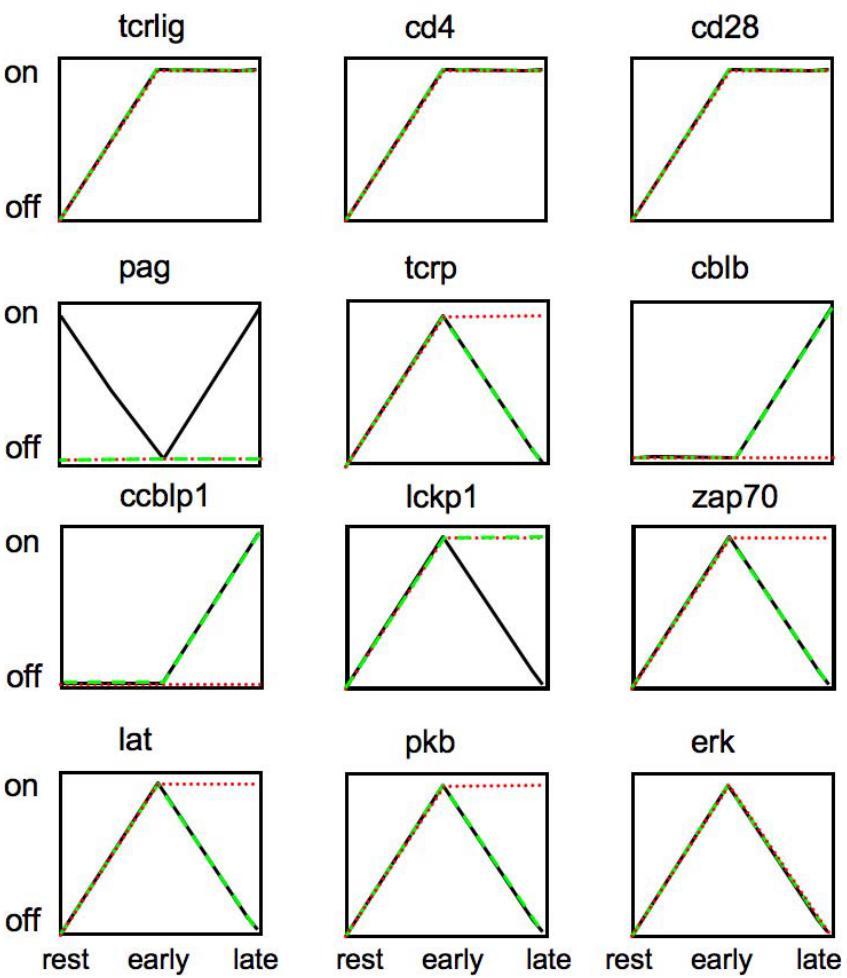
Figure 5. Considering Different Time Scales, a Rough Description of the Dynamics Can Be Obtained The activation of key elements upon activation of the TCR, the coreceptor CD4, and the costimulatory molecule CD28 is represented at the resting state, s ¼ 0 (no inputs); early events s ¼ 1 (input(s), no feedback loops); and later-time events, s ¼ 2 (input(s), feedback loops). The black lines correspond to a wild type while the green ones to a PAG KO. Note that the absence of PAG has no effect on key downstream elements of the cascade, due to the redundant role of other negative regulatory mechanisms (degradation via c-Cbl and Cbl-b, Gab-2 mediated inhibition of PLC c 1). Multiple knock-out of these regulatory molecules leads to sustained activation of key elements (red lines).